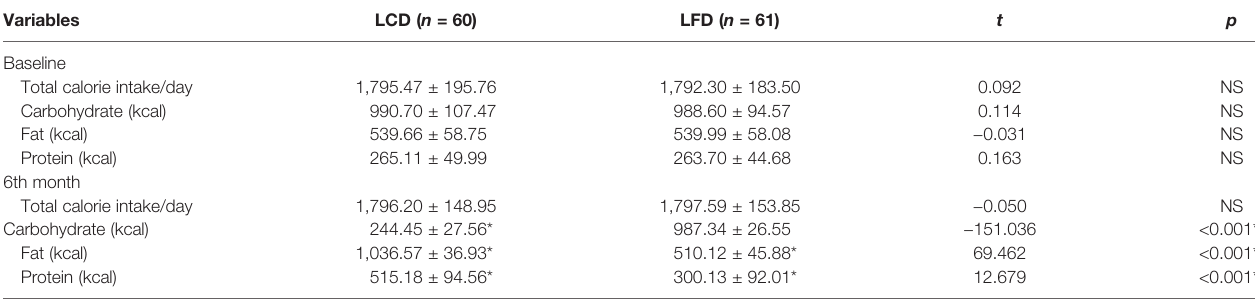
TABLE 3 | Comparison of the calories from three macronutrients consumed by the patients. Variables